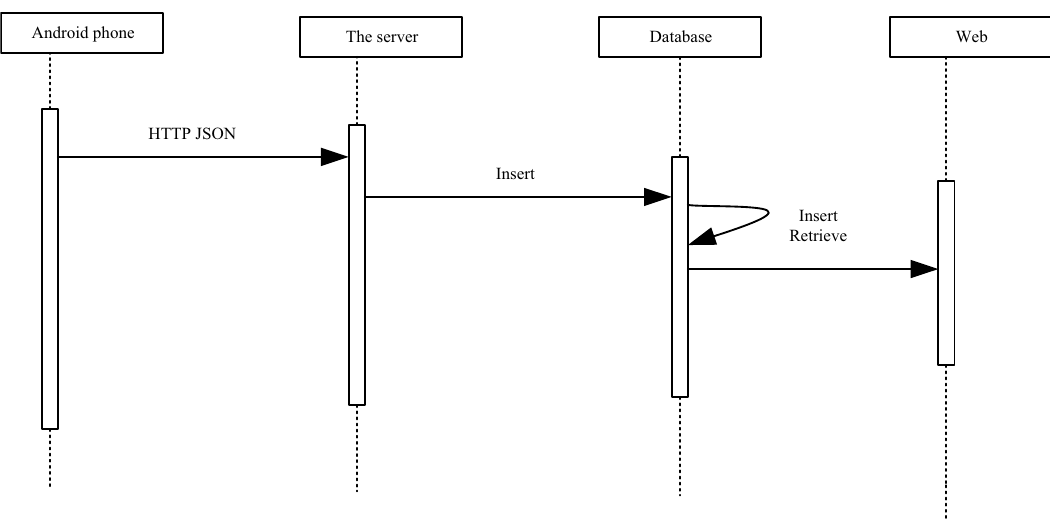
Figure 4: Sequence diagram of information